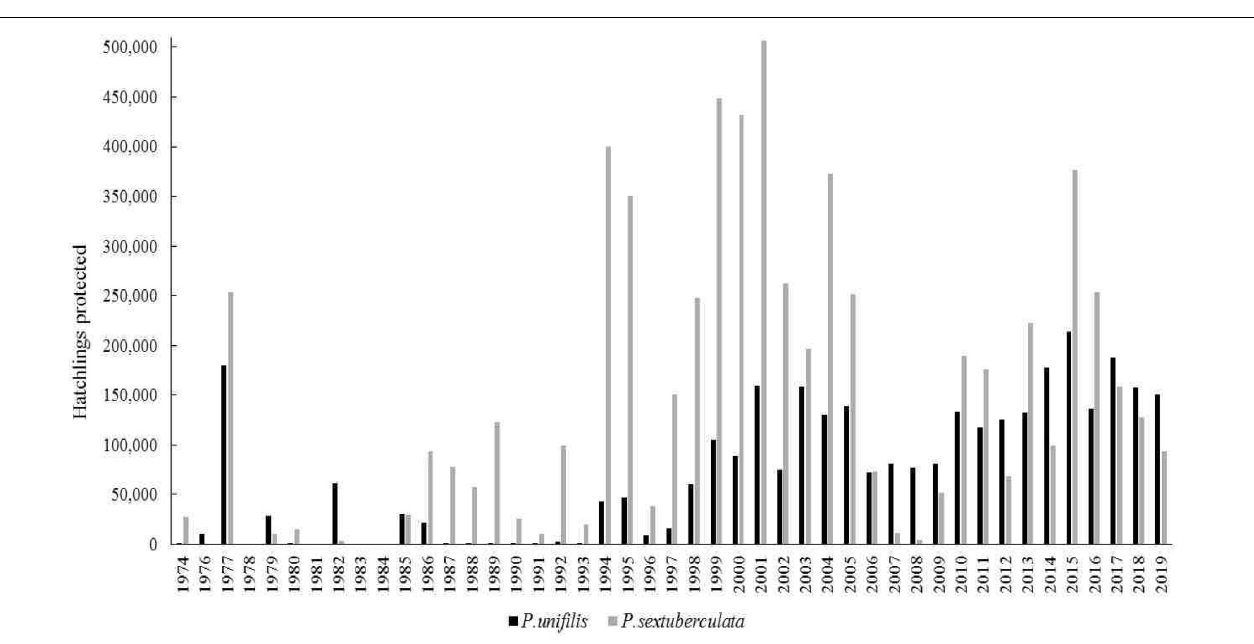
FIGURE 3 | Yellow-spotted river turtle ( P. unifilis ) and six-tubercled river turtle ( P. sextuberculata ) hatchlings protected between 1974 and 2019 in the Amazonas state and the northwestern section of the Pará state, Brazil. Source: PQA/IBDF/IBAMA CPPQA and Pé-de-pincha program technical